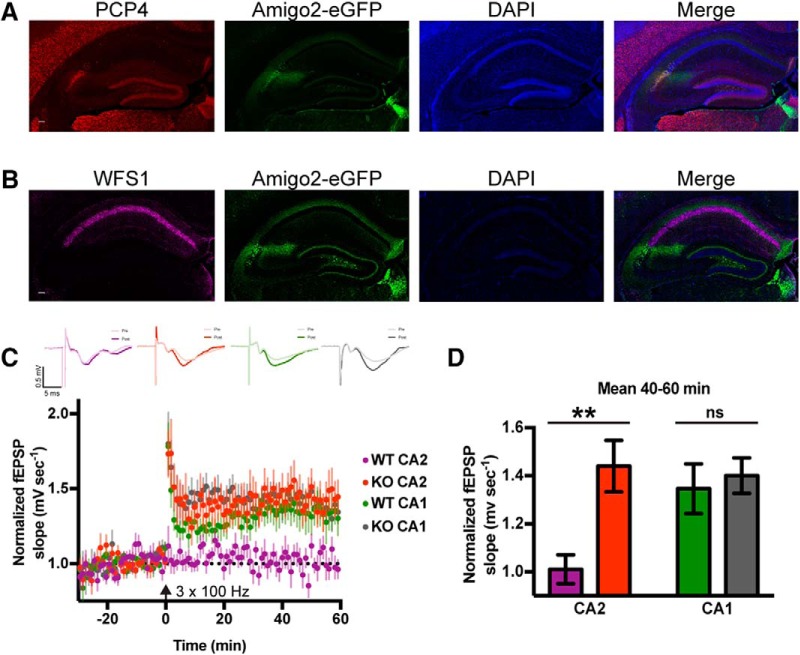
RGS14 KO mice exhibit plasticity of CA2 synapses into adulthood. A, Amigo2-EGFP fluorescence (green) labels CA2 pyramidal neurons as shown by overlap with another CA2 molecular marker PCP4 (red). Scale bar = 100 μm. B, Amigo2-EGFP fluorescence (green) does not colocalize with immunoreactivity for the CA1 pyramidal neuron marker WFS1 (magenta). Scale bar = 100 μm. C, Summary graph of field potential recordings from acute hippocampal slices prepared from adult RGS14 WT and KO mice (both Amigo2-EGFP+) validate that RGS14 KO mice possess a capacity for LTP in CA2 in adulthood (red), which is absent in WT mice (purple). RGS14 WT and KO mice do not differ in CA1 plasticity (green, gray). LTP was induced by high-frequency stimulation (HFS; 3 × 100 Hz) at time 0 (arrow). Data are represented as mean normalized fEPSP slope ± SEM (dotted reference line at 1.0). Sample sizes (in slices/animals) are WT CA2 n = 14/5; KO CA2 n = 16/4; WT CA1 n = 17/4; KO CA1 n = 12/5. Insets (top) are representative traces of field potentials recorded from areas CA2 and CA1 from slices of RGS14 WT and KO mice before (light line) and after (heavy line) LTP induction. D, Quantification of the mean normalized fEPSP slope 40-60 min following LTP induction (C) with error bars representing SEM. The difference in the degree of LTP induced in RGS14 WT and KO CA2 synapses was significant, whereas no difference was detected between RGS14 WT and KO synapses recorded in CA1. Sidak’s, **, p ≤ 0.01, ns = not significant.